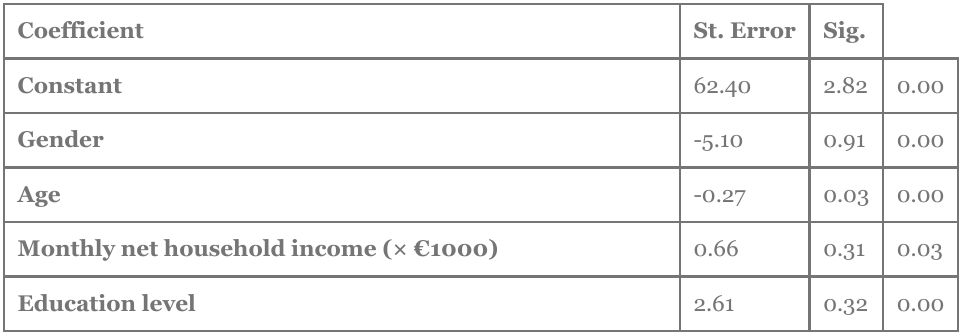
Table 2: Demographic factors driving acceptance of pricing